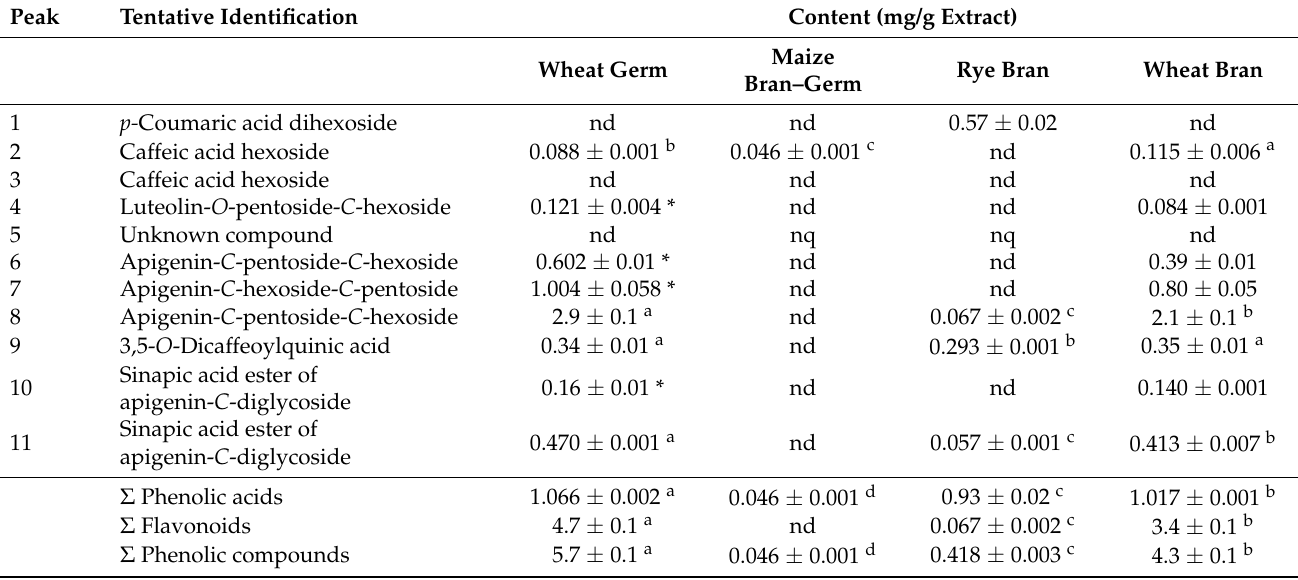
Table 5. Phenolic compounds content in the hydroethanolic extracts of the cereal